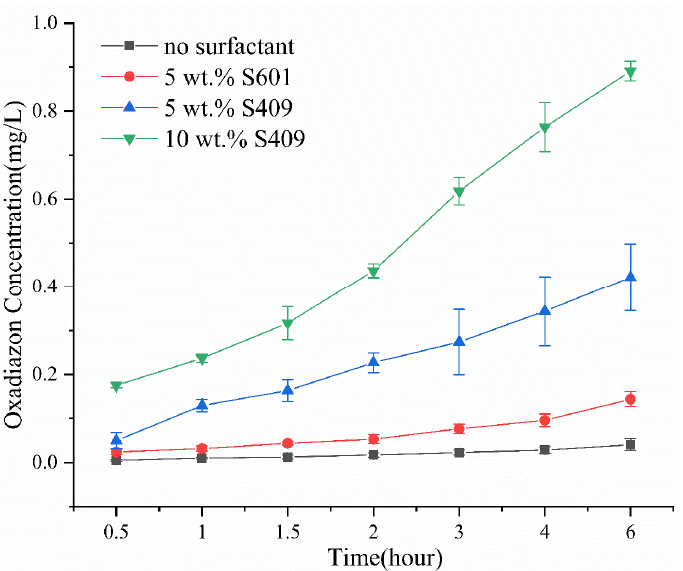
Figure 4. Concentration of oxadiazon in water at different times and 0.5 m from the deposition point, after depositing SO containing different types and concentrations of